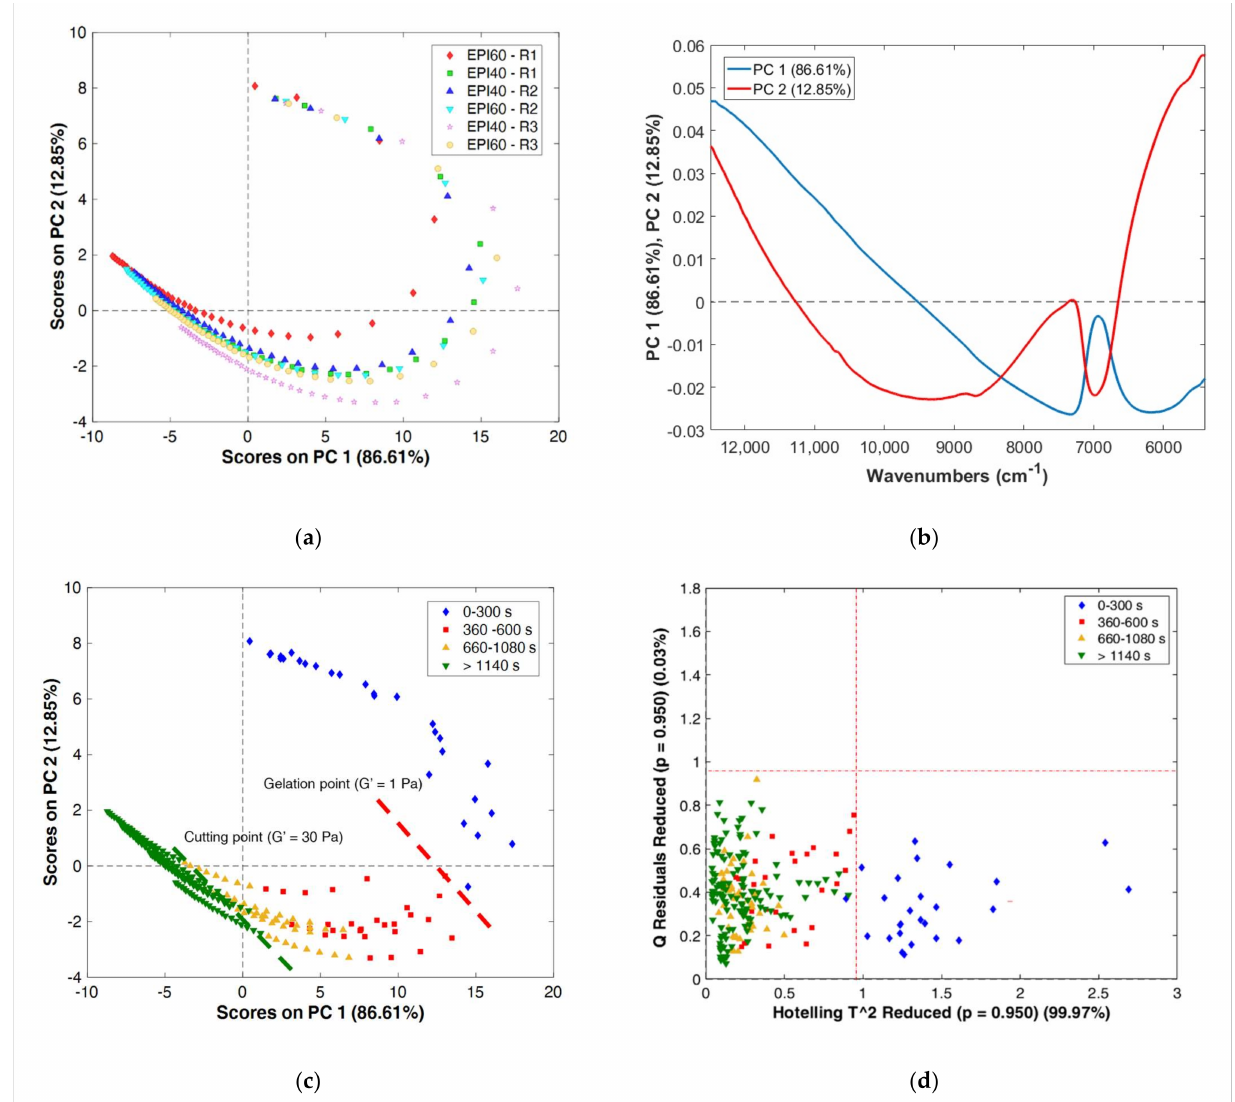
Figure 3. Principal component analysis of the calibration dataset: ( a ) score plot PC1 vs. PC2 with samples coloured according to the trial; ( b ) loading plot of PC1 and PC2; ( c ) score plot PC1 vs. PC2 with samples coloured according to coagulation time; ( d ) Q-residuals vs. T 2 plot with samples coloured according to coagulation time. R1, R2 and R3 correspond to the three replicates of each mix ratio